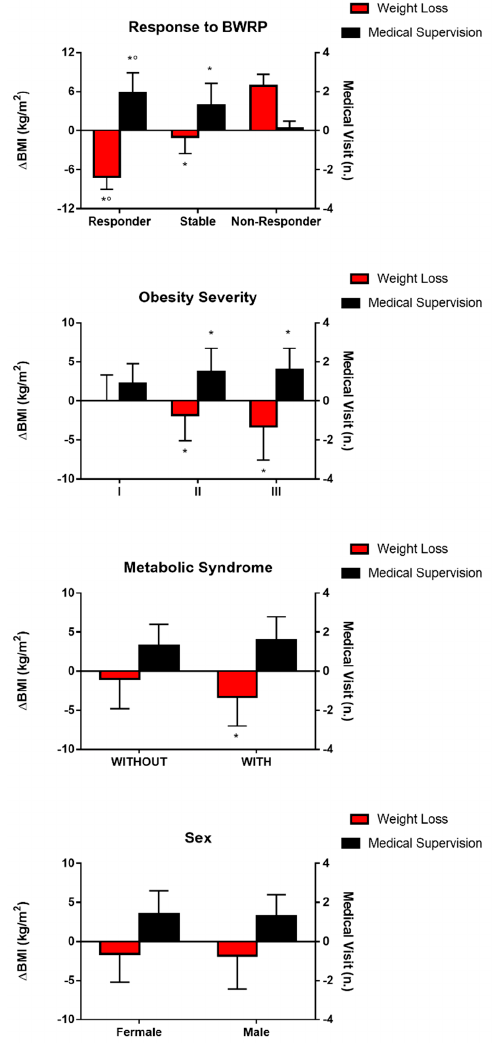
Figure 2. Weight loss ( Δ BMI, i.e., [BMI T2 –BMI T1 ]) and medical supervision (i.e., number of any kind of medical visit occurred in-between the BWRPs at T1 and T2) in four different subdivisions of the population of children/adolescents with obesity: (1) responsive ( Δ BMI, i.e., [BMI T2 –BMI T1 ] < − 5 kg/m 2 ), stable (> − 5 and <5 kg/m 2 ) and non-responsive (>5 kg/m 2 ) subjects (first panel); (2) class 1 obesity (BMI T1 ≥ 95th percentile to <120% of 95th percentile for age and sex), class 2 obesity (BMI T1 ≥ 120% to <140% of 95th percentile or BMI ≥ 35 kg/m 2 ) and class 3 obesity (BMI T1 ≥ 140% of 95th percentile or BMI ≥ 40 kg/m 2 ) (second panel); (3) with and without metabolic syndrome (third panel); (4) females and males (fourth panel). * p < 0.05 vs. non-responsive subjects or class 1 obesity or without metabolic syndrome; ° p < 0.05 vs. stable subjects.